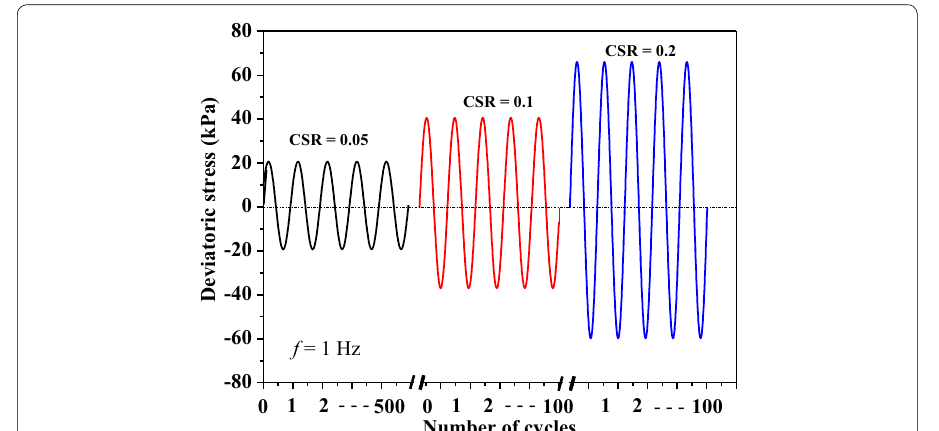
Fig. 5 Typical stress-controlled staged cyclic loading as used in the present